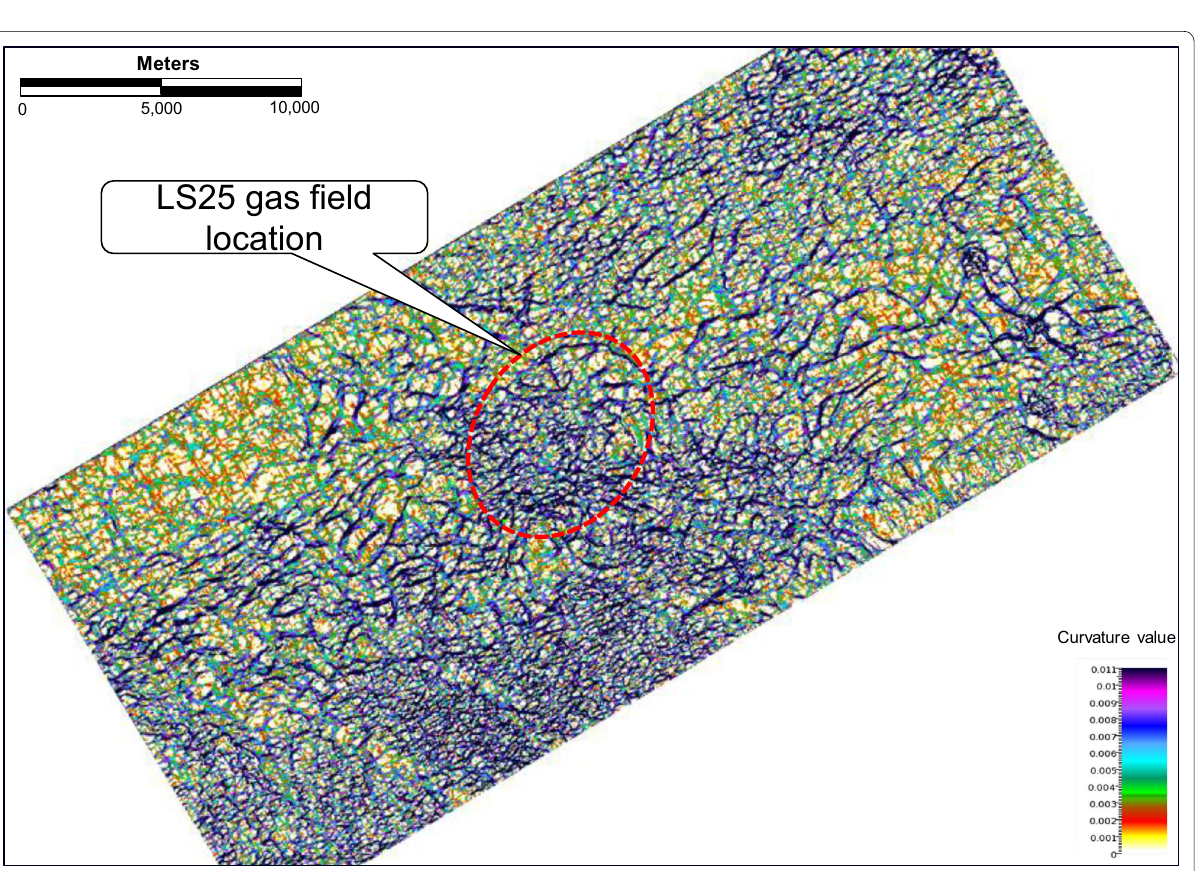
Fig. 11 The most positive curvature seismic attributes in LS25 gas field showing the fractured network for hydrocarbon migration and accumula- tion in work area C (location is shown in Fig.